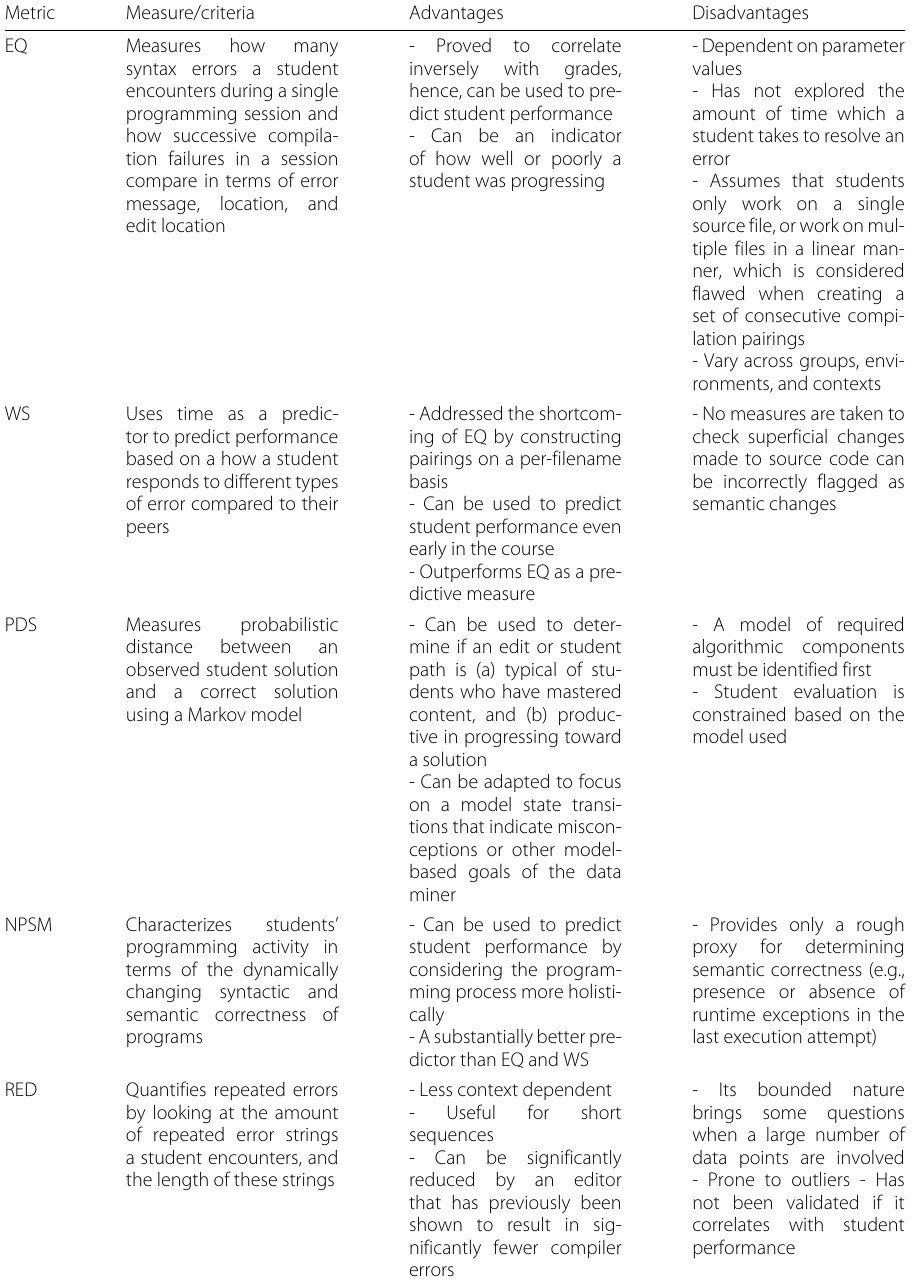
Table 5 Comparison of the five metrics